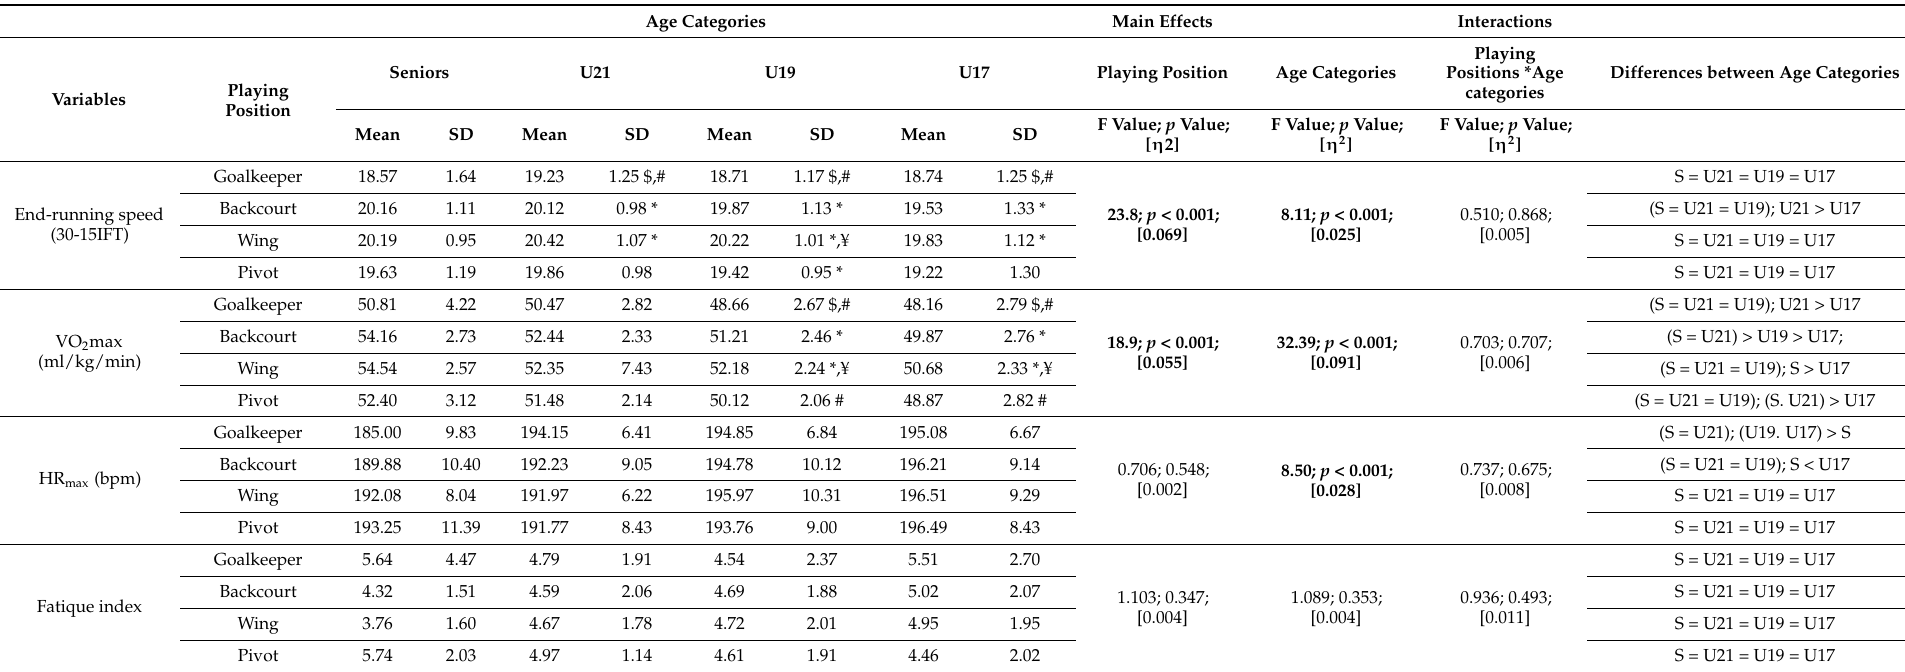
Table 4. The cardiorespiratory fitness profile of elite handball players based on age category and playing